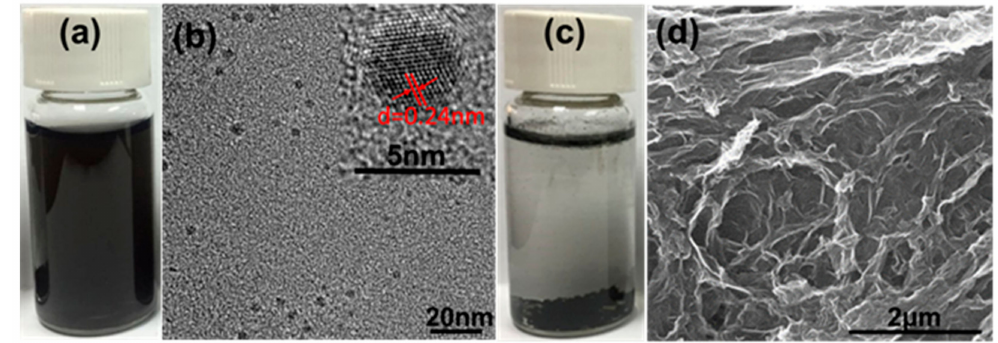
Figure 6. ( a ) Picture and ( b ) TEM and HRTEM (inset) images of GQDs by hydrothermal treatment of GO-QDs. ( c ) Picture and ( d ) SEM image of product after hydrothermal treatment of